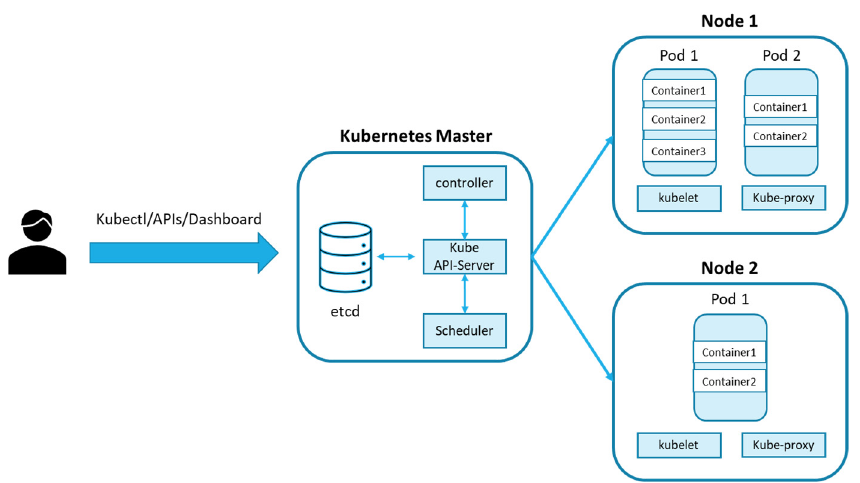
Figure 3. The Kubernetes master nodes-based architecture.